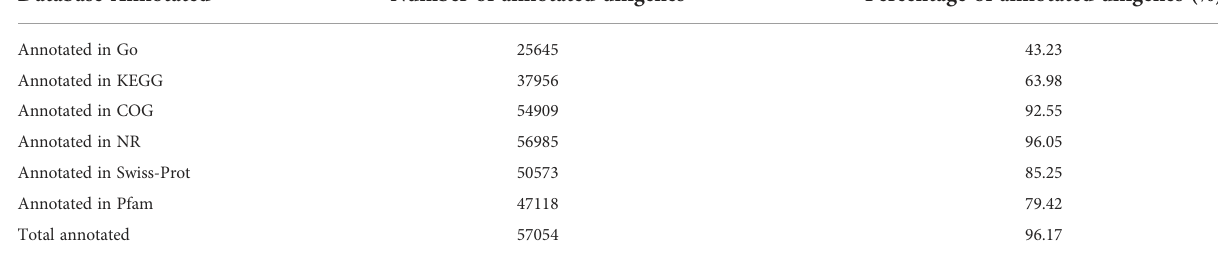
TABLE 2 Annotation summary of gold fi sh gill tissue